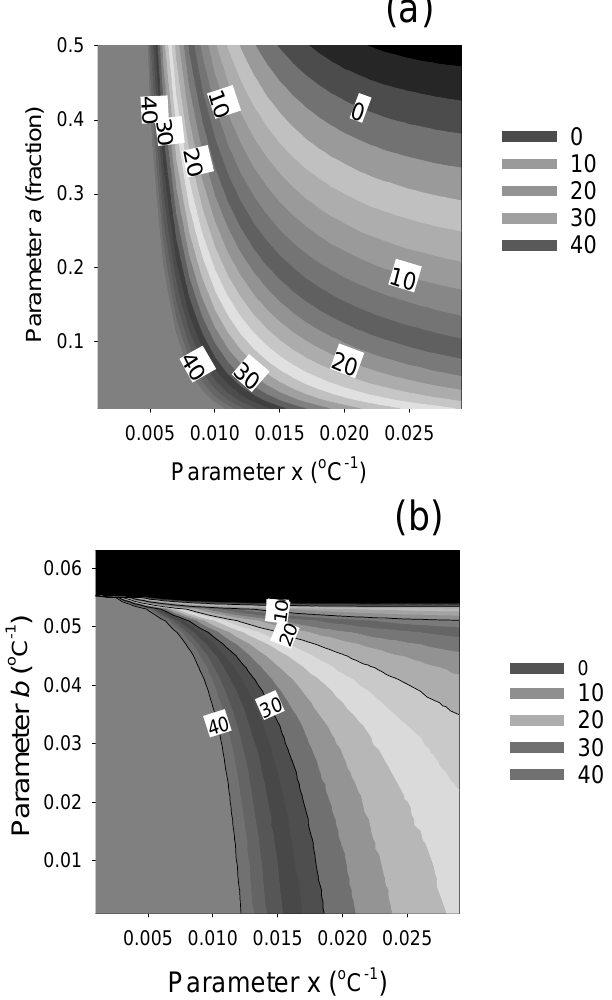
Figure 3. (a) Variation in T x , or the soil temperature at which the equilibrium soil carbon pool is minimum, with the temperature sen- sitivity of microbial growth efficiency ( x ) and the fraction of carbon input directly into soil carbon pool ( a ). µ b was fixed at 1.1yr − 1 (or b = 0) for this plot. (b) Variation in T x with x and b . Parameter a was fixed at 0.05 for plot (b) . The unit is ◦ C for all the numbers along the contour lines in both (a) and (b) . The black region in (b) represents T x <0 ◦ C.